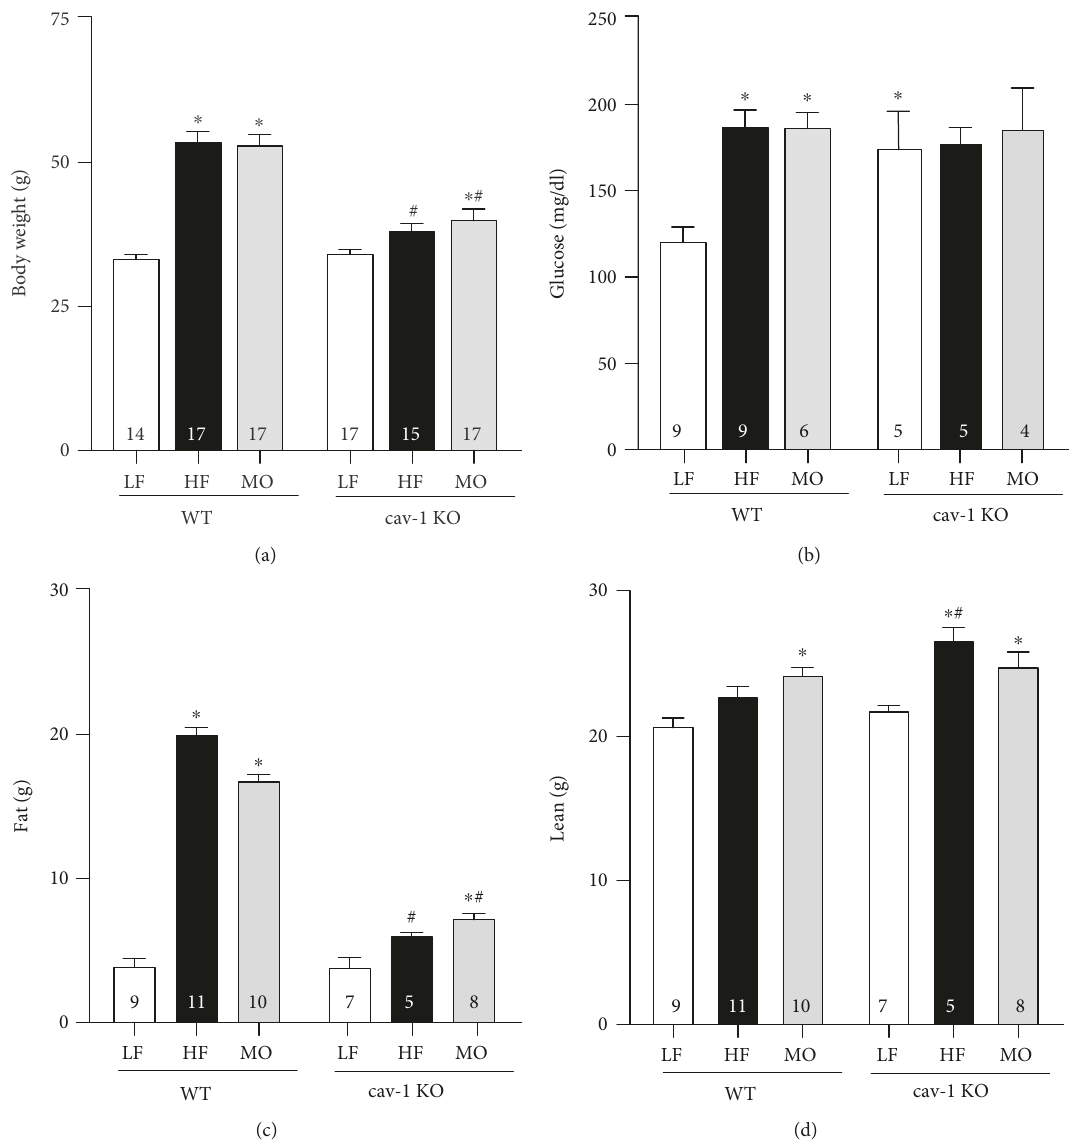
Figure 1: Body weight (a, g), fasting glucose (b, mg/dl), body fat (c, g), and lean mass (d, g) of WT and cav-1 KO mice on LF, HF, and MO diets. Mean ± SEM , n per group within each bar, ∗ p < 0 05 vs. LF within the same genotype, # p < 0 05 vs. WT mice on the same diet. ANOVA followed by Tukey ’ s multiple comparison